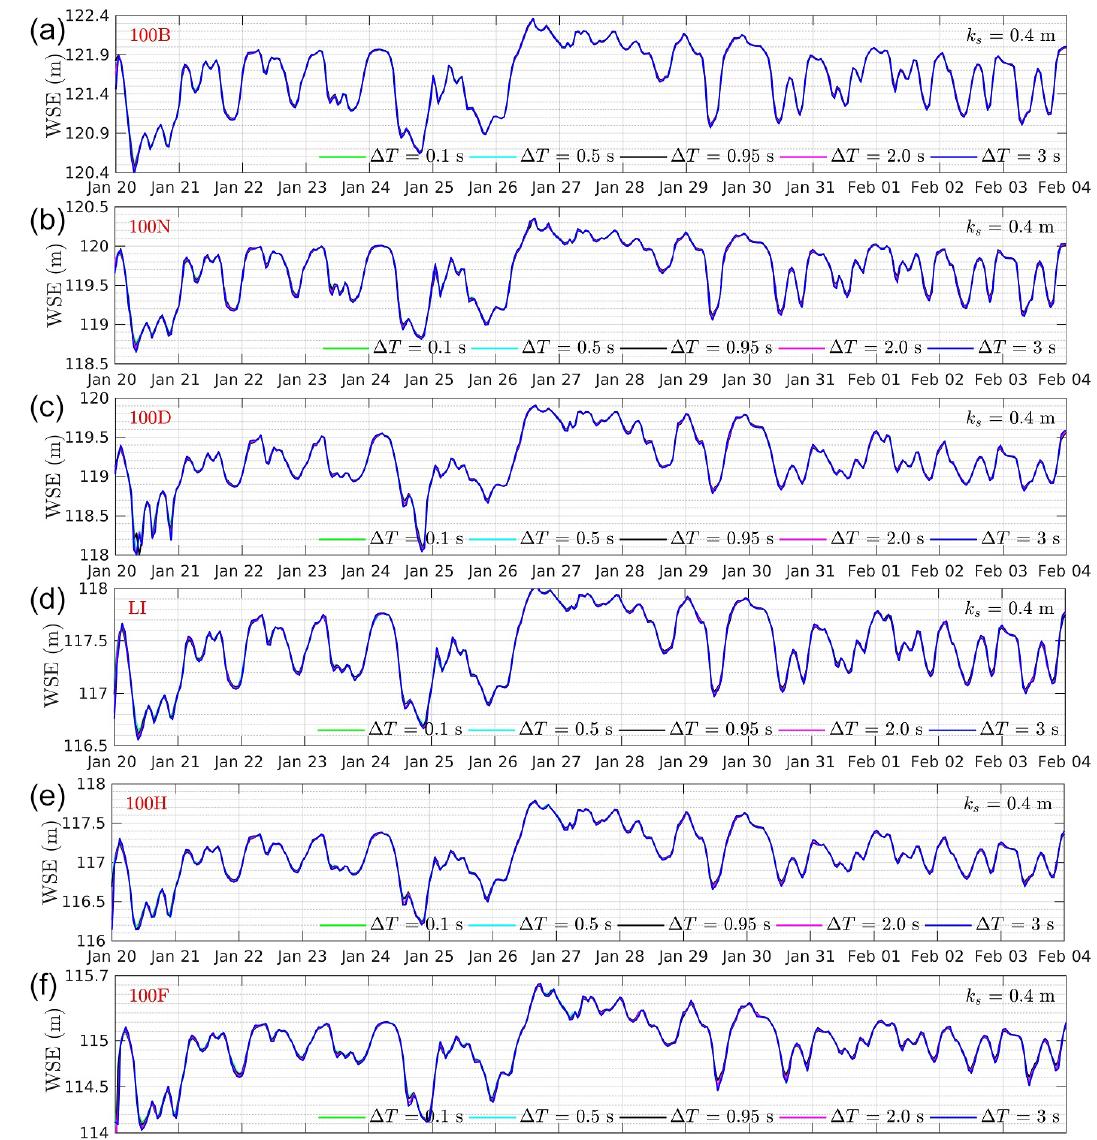
Figure A4. A comparison of WSE at different time steps at 100B, 100N, 100D, LI, 100H, and 100F.